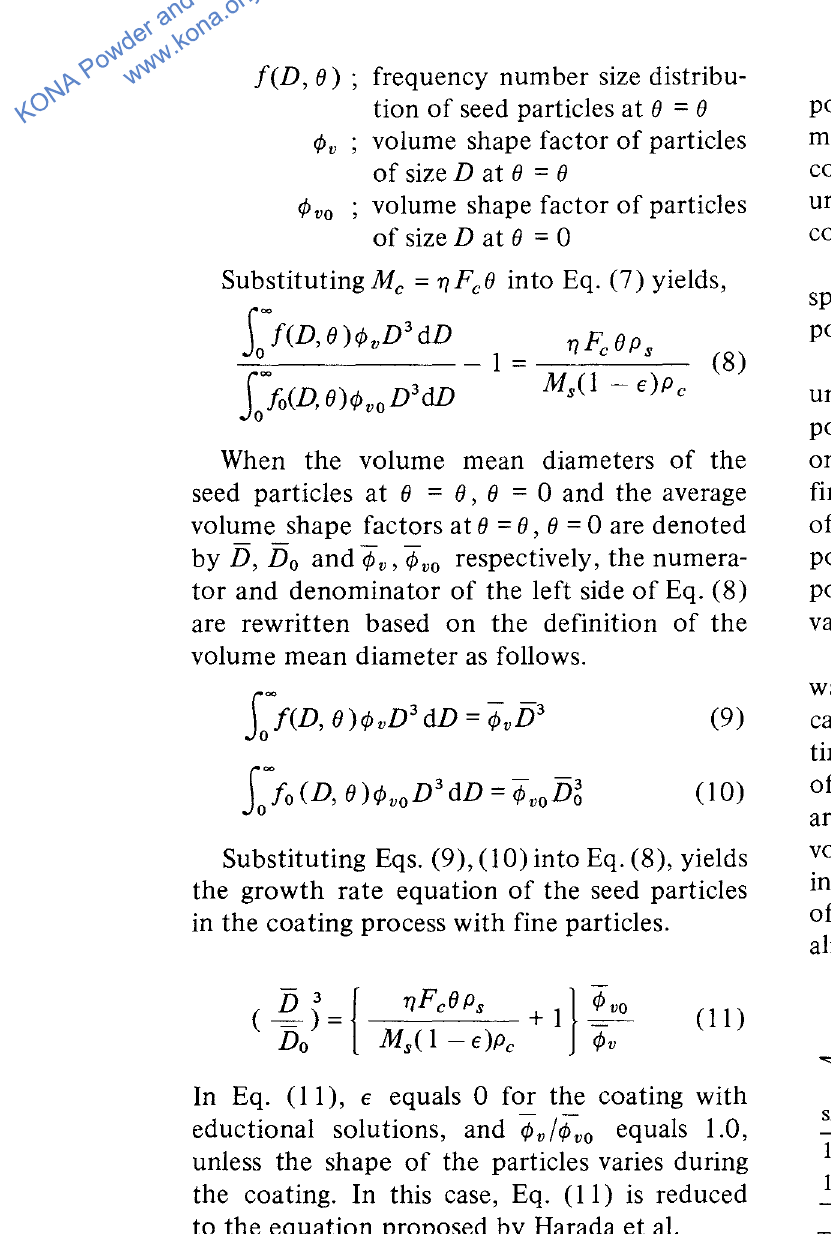
Table 3 Measured values of porosity of coating layer